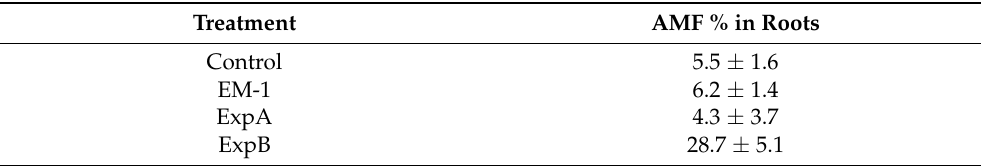
Table 6. Arbuscular mycorrhiza fungi (AMF) colonization of creeping bentgrass roots at 56 DAT in response to exposure to the untreated control, EM-1, ExpA and ExpB.